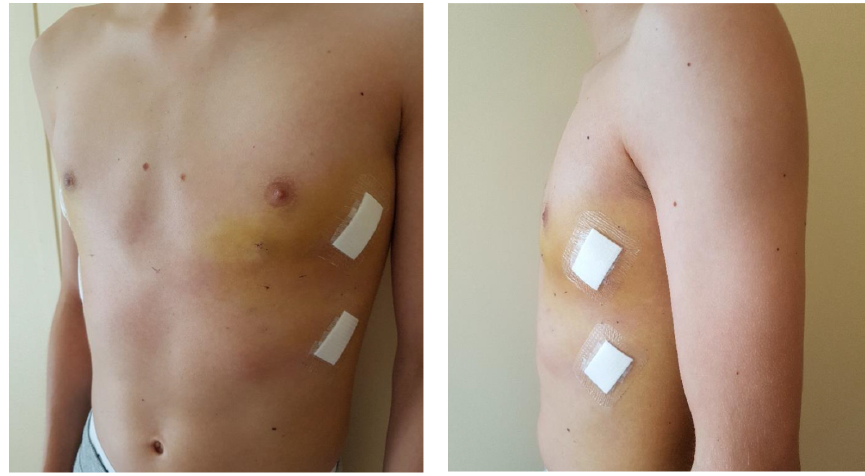
Figure 6. 17 years old male patient with PE and bilateral costal flaring, after MIRPE (Cross bar technique); notice mild hematoma as side effect of intraoperative application of the vacuum bell.